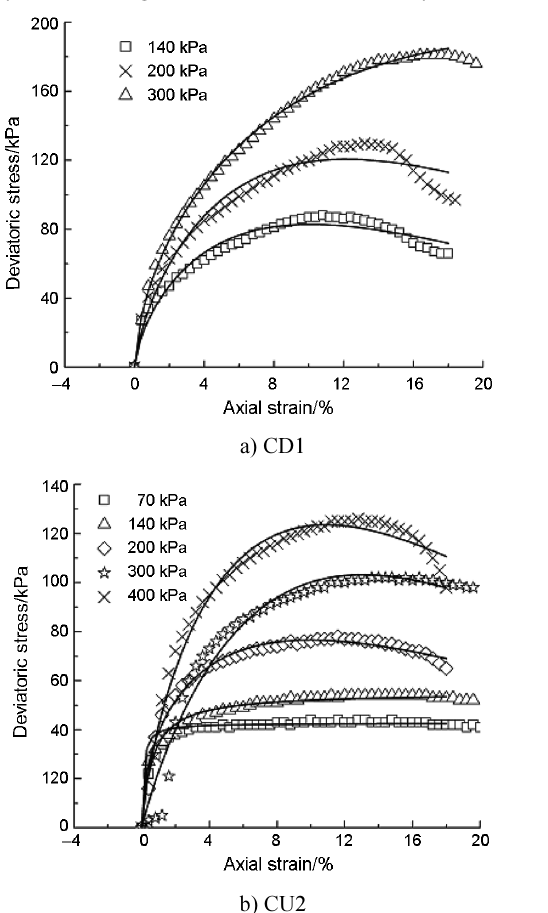
Fig. 1. Fitting stress-strain curves for partial